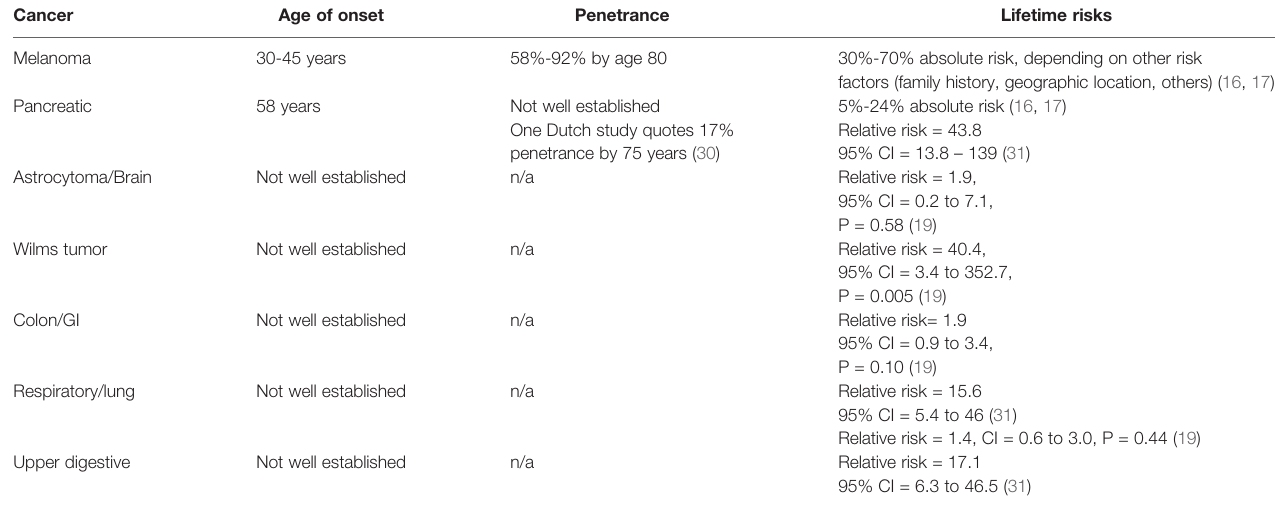
TABLE 1 | Summary of data on age of onset, penetrance and lifetime risks of FAMMM-associated